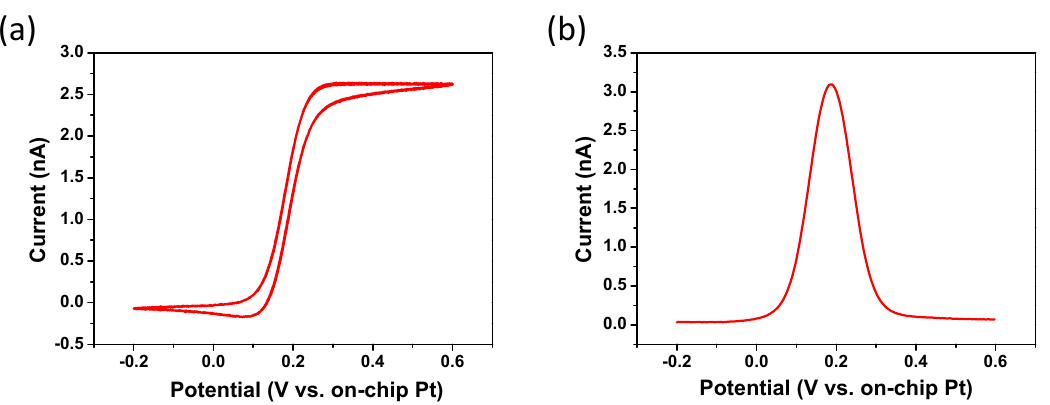
Figure 2. ( a ) CV and ( b ) SWV of 1 mM FCA in 10 mM PBS, pH 7.4, at 100 mV s − 1 vs. on-chip Pt pseudo-reference electrode; illustrating the steady-state behavior of a 4 × 100 nm nanowire array separated by a distance of 500 nm.